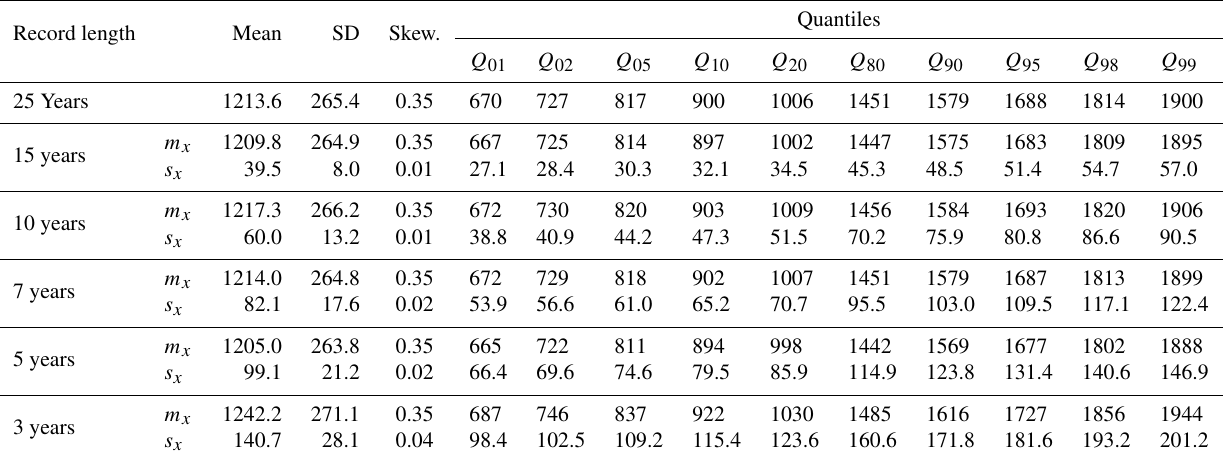
Table A1. Mean, standard deviation (SD), selected quantiles (in millimeters), and skewness of the annual rainfall in Concepción, as obtained with derived distributions for the 25-year complete record and for shorter, resampled records of lengths 15, 10, 7, 5, and 3 years ( m x and s x are the mean and standard deviation of each statistic, for the 200 resampled records).